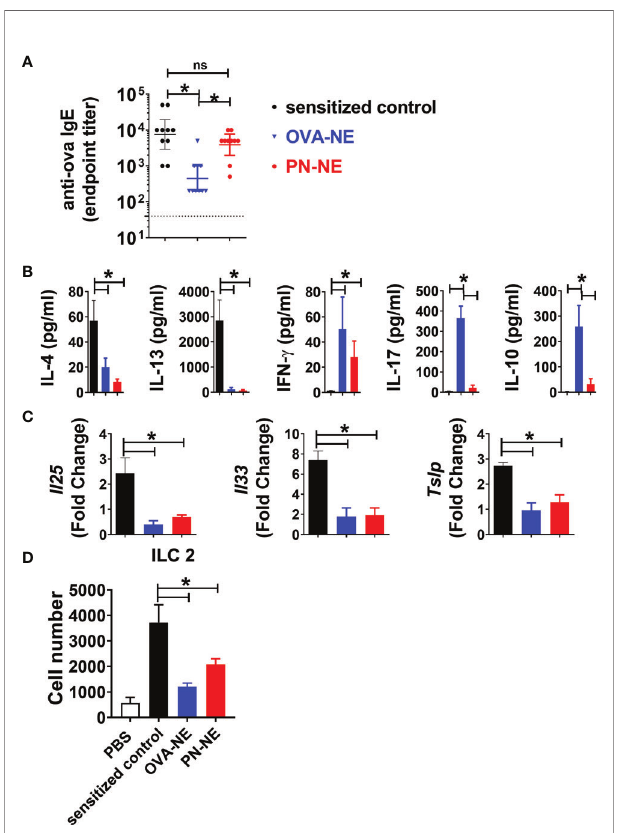
FIGURE 4 | NE immunotherapy induces antigen-speci fi c and bystander suppression of Th2 cytokines and alarmins. As described in Figure 1A , mice were sensitized with OVA and peanut-alum and treated i.n. with 3 administrations of PBS (sensitized control), OVA-NE or peanut-NE (PN-NE). Mice were challenged orally with OVA, and (A) OVA-speci fi c IgE was measured in serum obtained after the fi nal challenge and (B) OVA-speci fi c cytokine secretion was determined in cultures of mLN lymphocytes. (C) Duodenum samples were homogenized and mRNA extracted to determine relative gene expression compared to GAPDH. (D) Total number of ILC2 (Lin- CD45+ CD127+ CD90.2+ KLRG1+ GATA3+) from SI. Statistically signi fi cant differences (p < 0.05) are indicated by *.